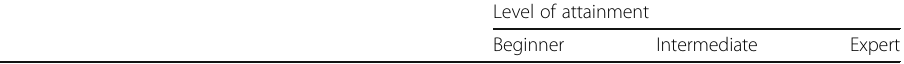
Table 1 An example of knowledge and skills required of a science teacher teaching lower primary science Subject Matter Knowledge (MOE, 2014,